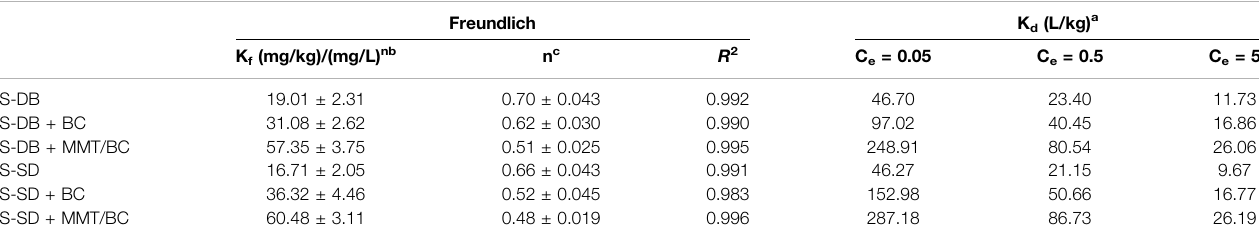
TABLE 3 | Freundlich model of sorption isotherms of atrazine on soils and biochar – soil mixtures.